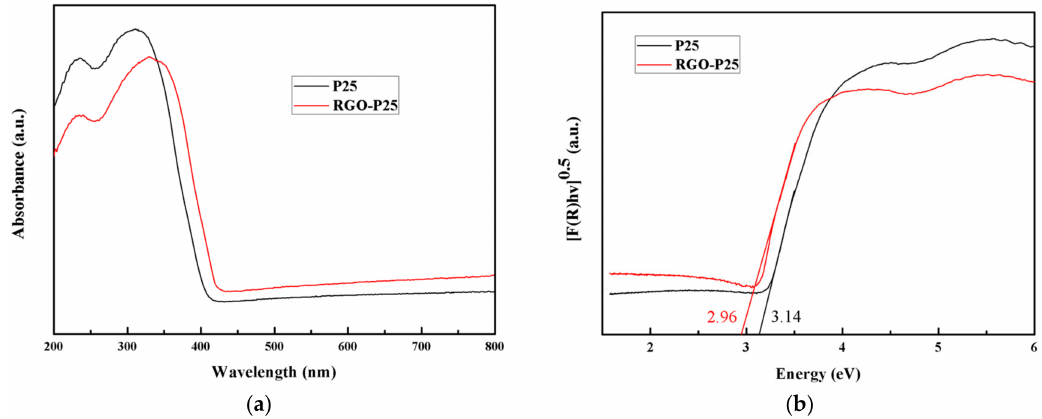
Figure 5. UV-vis diffuse reflection spectra spectroscopy ( a ) and the band gap ( b ) of P25 and